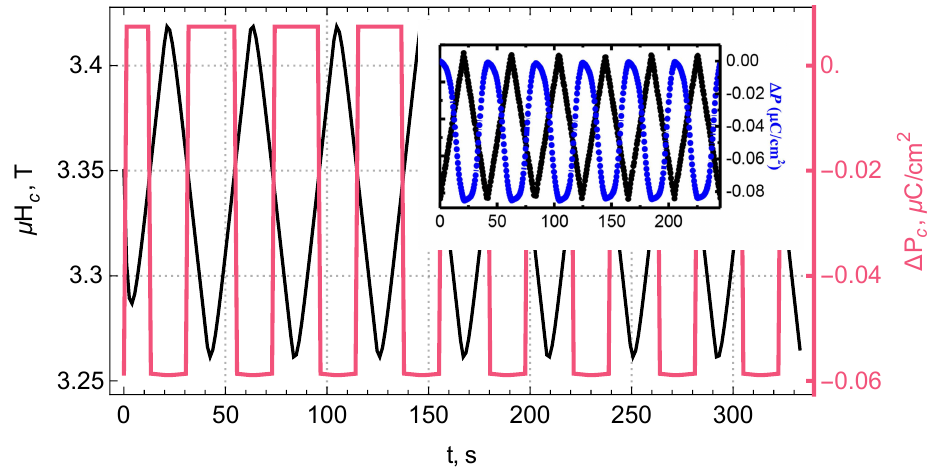
Figure 5. Modeled quasi–linear magnetoelectric effect at the AFM–FRM phase boundary. The magnetic field is modulated with time t by a triangular function with an amplitude of 0.2 T similar to the experiment near 3.25 T—the critical field of the transition to the ferrimagnetic phase. The inset shows the experimental plots from [1]—periodic modulation of electric polarization (blue) induced by a magnetic field (black) linearly varying between 3.25 T and 3.5 T at T ∼ 58